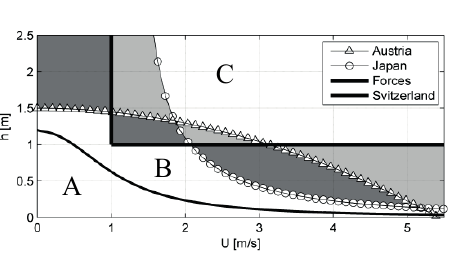
Fig. 7 Comparison of the presented methodologies with reference to the case